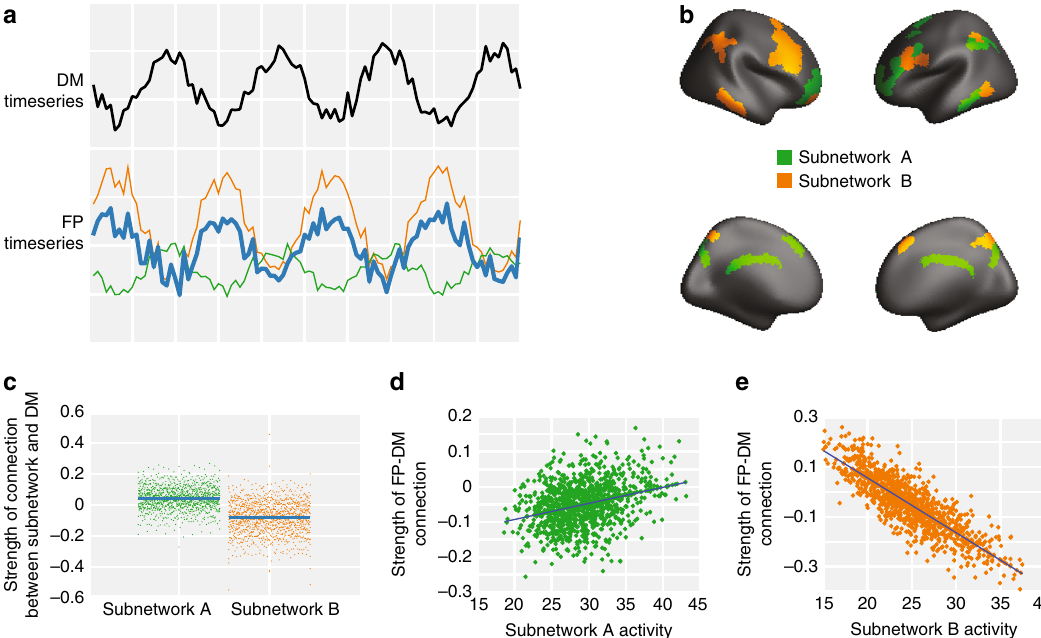
Fig. 1 Subnetworks of the frontoparietal system. a We hypothesized that the strength of the connection between the frontoparietal and default-mode systems can be tuned by altering the relative amplitudes of subnetworks within the frontoparietal system. b Community detection reveals two distinct frontoparietal subnetworks, which we show here projected onto the cortical surface. c We found that the activity of subnetwork (A) was positively correlated with the activity of the default-mode system (mean r = 0.042, p < 0.001, t (1206) = 20, 95% CI: [0.038, 0.046]), while the activity of subnetwork (B) was negatively correlated with the activity of the default-mode system (mean r = − 0.082, p < 0.001, t (1206) = − 27, 95% CI: [ − 0.088, − 0.076]). d Using a simple regression model, we tested whether the strength of the functional connection between the default-mode and frontoparietal systems could be predicted by a linear combination of the activity of subnetwork (A) and the activity of subnetwork (B). Within this model, we found that an increase in subnetwork (A) activity corresponds to an increase in the strength of the functional connection between the frontoparietal and default-mode systems (estimate of regression coef fi cient β = 0.006535, 95% CI: (0.00519, 0.00788), p < 0.001, t (1204) = 9.54). e Conversely, within the same model, we found that an increase in subnetwork (B) activity corresponds to a decrease in the strength of the functional connection between the two systems (estimate of regression coef fi cient β = − 0.0112, 95% CI: ( − 0.01273, − 0.0097), p < 0.001, t (1204) = −